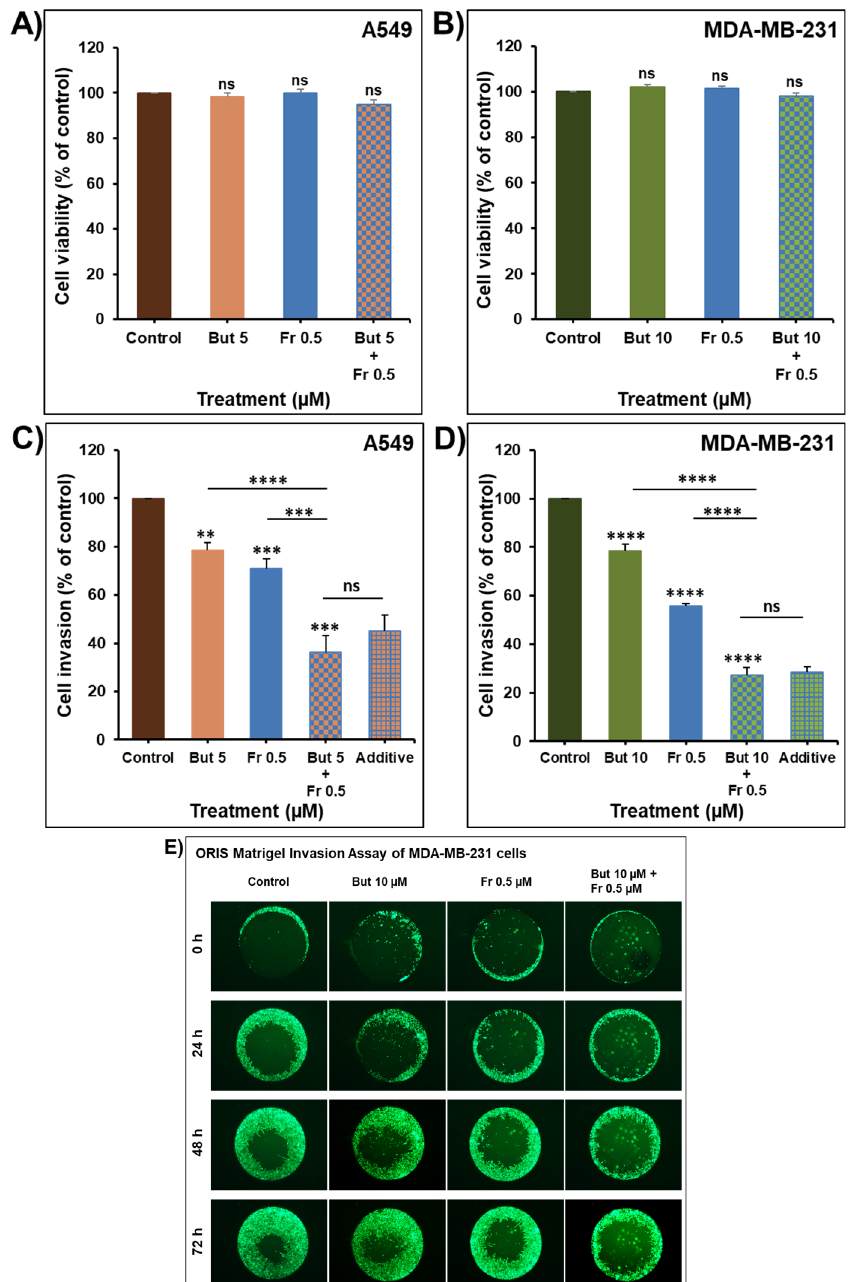
Figure 9. Impact of butein combination with frondoside-A on cellular invasion. A549 ( A ) and MDA- MB-231 ( B ) cells were treated for 24 h with butein (5 and 10 µ M, respectively), frondoside-A (0.5 µ M), and their combination. The effect on cell viability was determined as previously described. Using a Boyden chamber Matrigel invasion assay, A549 ( C ) and MDA-MB-231 ( D ) cells were incubated for 24 h with the non-toxic concentrations of butein and frondoside-A and their combination. Cells that invaded the Matrigel and crossed the 8 µ m pores were determined using the CellTiter-Glo Luminescent Cell Viability Assay. ( E ) Oris Matrigel invasion assay showing an enhanced suppression of MDA-MB-231 cell invasion in the combination of butein with frondoside-A compared to drugs alone. All experiments were repeated at least three times. Columns are means; bars are S.E.M. The statistical significance is compared to the control except for the specified lines. ** Significantly different at p < 0.01, *** Significantly different at p < 0.001, **** Significantly different at p < 0.0001. ns–not